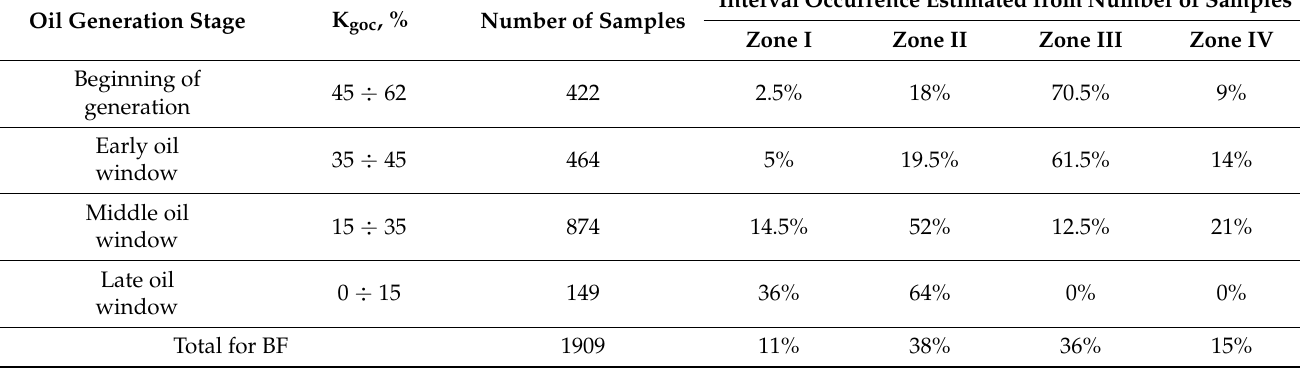
Table 3. Distribution of the studied samples over the identified production approaches zones. The estimations are given for each maturity